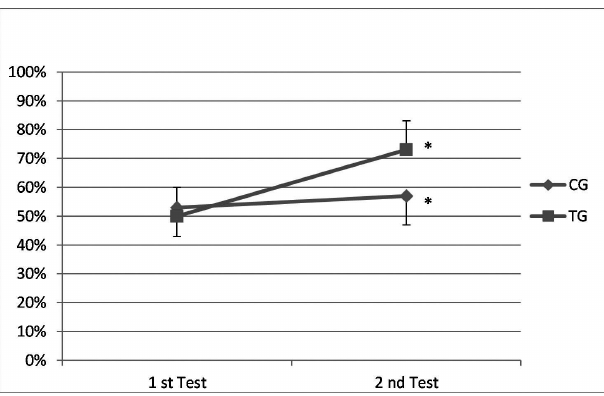
programsFig. 3 - Values of maximal inspiratory pressure expressed as percentage of predicted